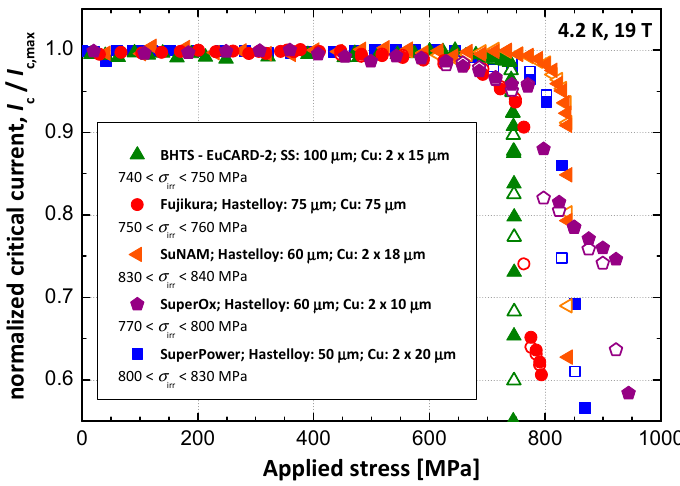
Figure 12. Normalized critical current I c /I c,max versus longitudinal tensile stress, σ , and irreversible stress limits, σ irr , at 4.2 K and 19 T for five industrial REBCO tapes. Adapted from Ref. [51].